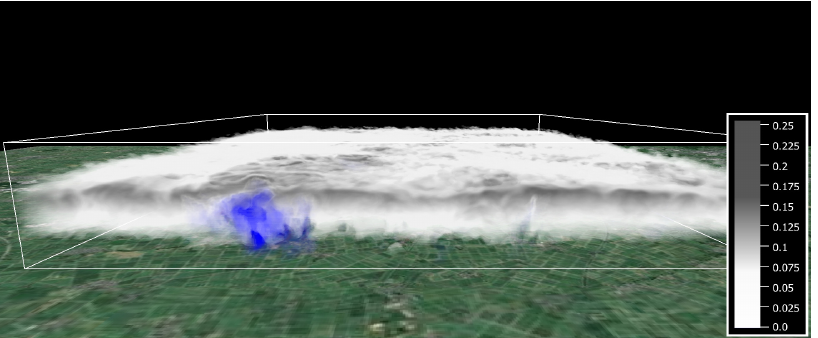
Figure 6. Snapshot of the cloud field from a PALM run for three continuous days of the HD(CP) 2 Observational Prototype Experiment. Shown is the 3-D field of q c (white to gray colors) as well as rainwater ( q r > 0, blue) on 26 April 2013. The simulation had a grid spacing of 50m on a 50 × 50 km 2 domain. Large-scale advective tendencies for θ l and q were taken from COSMOE-DE (regional model of the German Meteorological Service, DWD) analyses. The copyright for the underlying satellite image is held by Cnes/Spot Image,